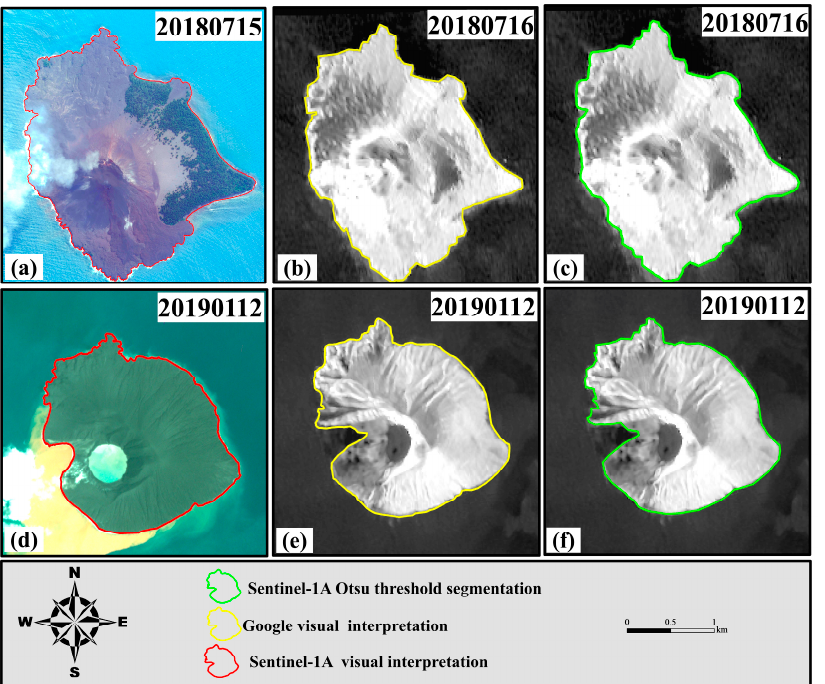
Figure 7. Volcano boundaries extracted from ( a ) the Google image on 15 July 2018 by visual interpretation; ( b ) the Sentinel-1A image on 16 July 2018 by visual interpretation; ( c ) the Sentinel-1A image on 16 July 2018 by the Otus threshold segmentation method; ( d ) the Planet image on 12 January 2019 by visual interpretation; ( e ) the Sentinel-1A image on 12 January 2019 by visual interpretation; ( f ) the Sentinel-1A image on 12 January 2019 by the Otus threshold segmentation method. Table 1. The volcano area obtained by different methods.